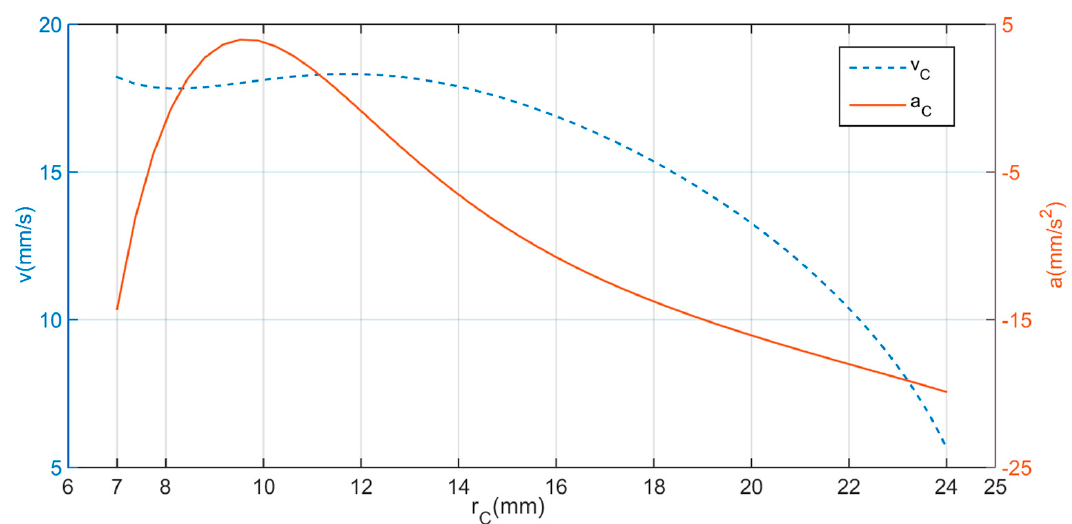
C . Figure 8. The velocity and acceleration curves with respect to the expanding radius of joint C